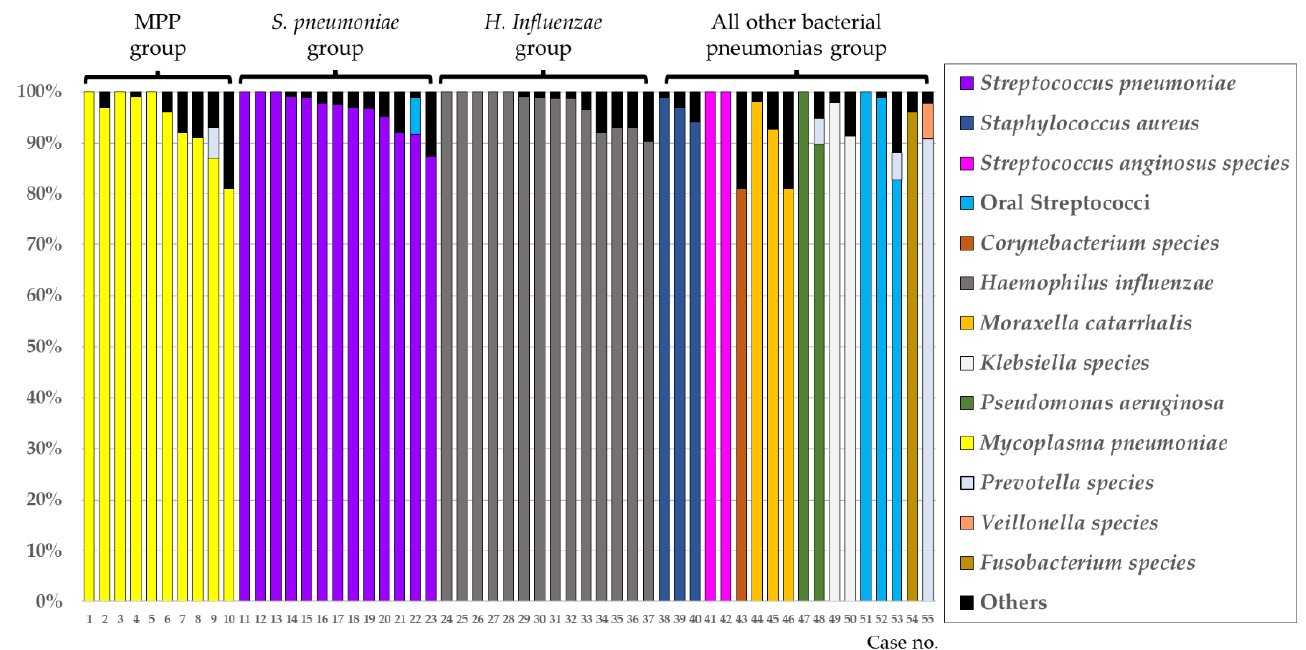
Figure 1. Percentage of detected phylotypes in “mono-bacterial” group using the molecular method. The percentage of phylotypes in each sample in the 55 patients in the mono-bacterial group. The phylotypes that dominated less than 5% in each library were classified as “Others.” Abbreviations: MMP, Mycoplasma pneumoniae pneumonia; S. pneumoniae , Streptococcus pneumoniae ; H. influenzae , Haemophilus influenzae .